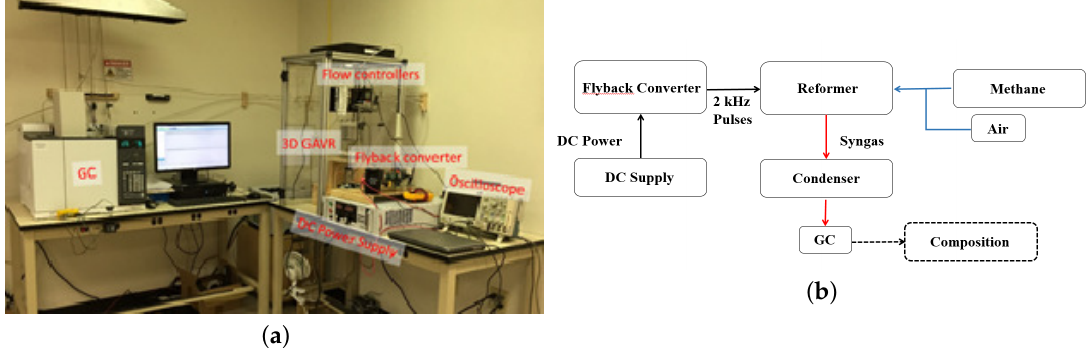
Figure 3. ( a ) Test setup; and ( b ) system lock diagram of